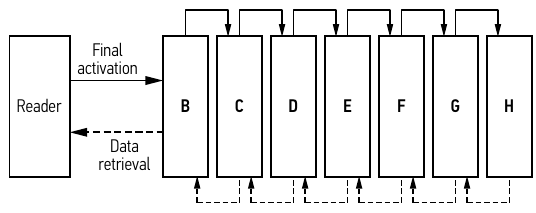
Fig. 5. Chosen RFID sensor network scheme